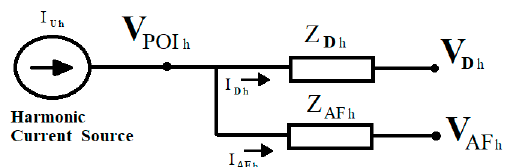
Figure 7. Simplified diagram of the active power filter application for parallel resonances.